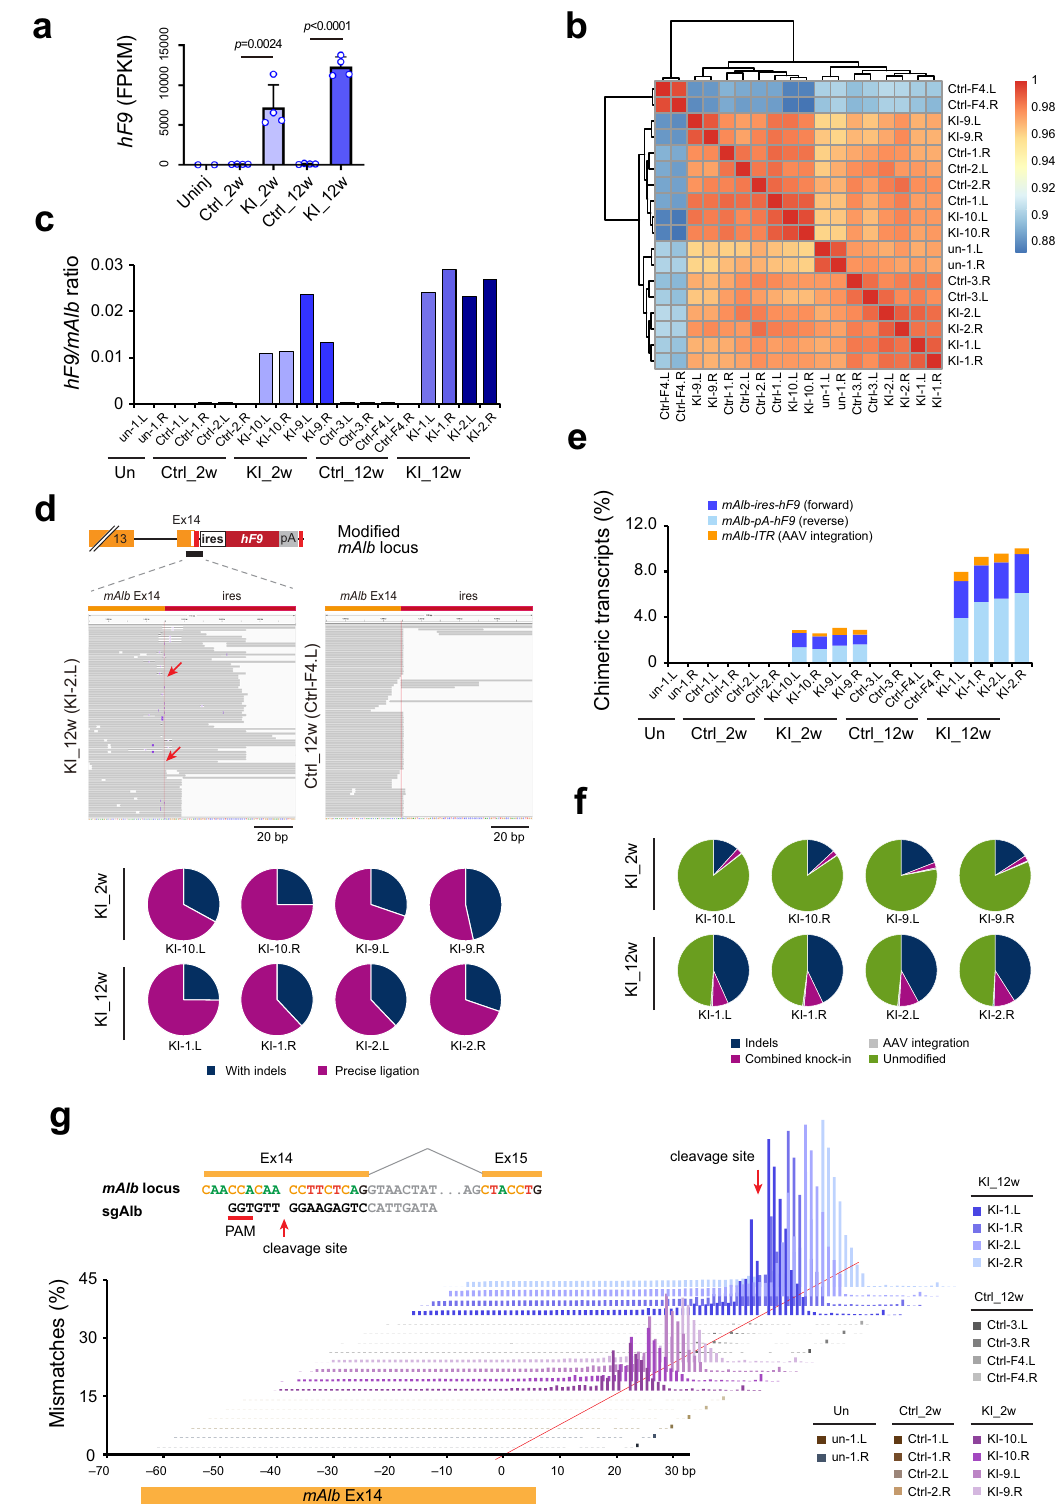
produced plasma hFIX-Padua at signi fi cant levels. Similar to the observations in adult AAV-KI ( hF9 ) mice (Fig. 1b), a steady increase of plasma hFIX-Padua in the fi rst 4 – 6 wpi was evident in all six groups (Fig. 5c, lower left). Effective hemostasis correction was achieved with AAV dose as low as 1 ×10 10 vg/mouse, which produced plasma hFIX- Padua ataround 350 ng/ml(Fig. 5c, lower,red circle).The relativehFIX activities among all treatment groups were restored signi fi cantly since